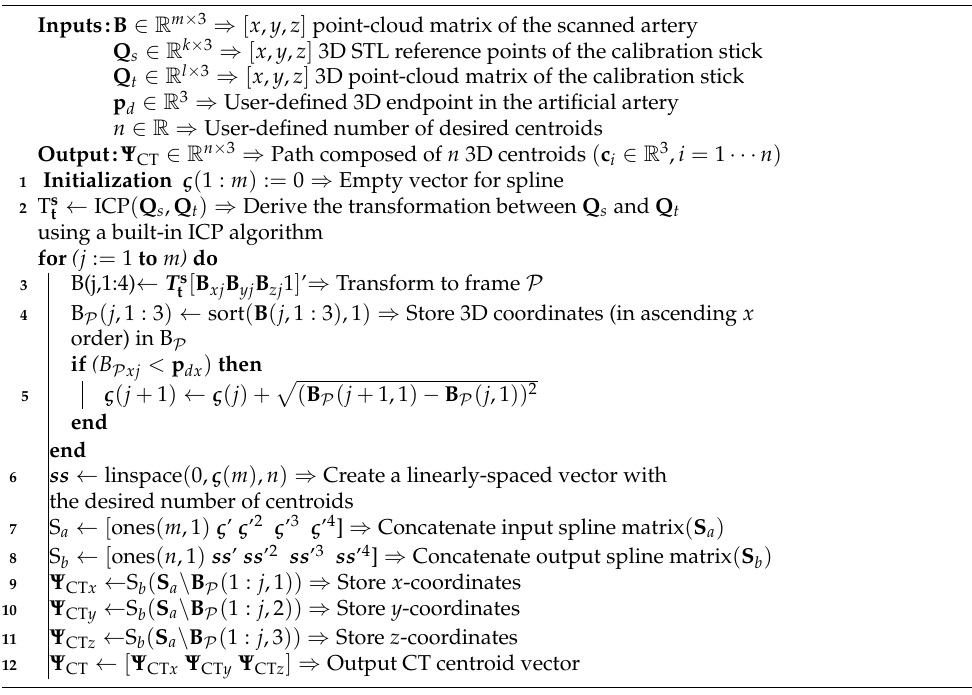
Algorithm 1 3D centroid generation inside an arterial volume Algorithm 1: 3D centroid generation inside an arterial volume.